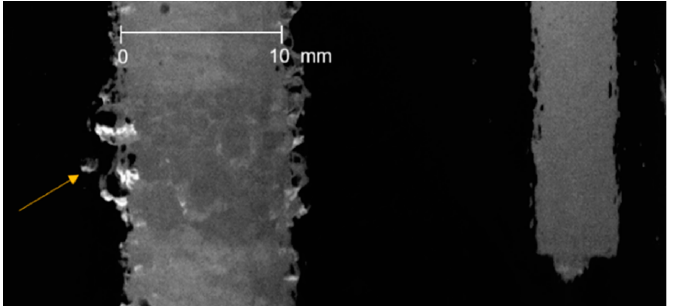
Figure 16. One small bubble (yellow arrow pointing) is detaching from the vertical surface (at the left) at a constant current density of 0.1 A cm − 2 . A scale bar is shown in the figure.